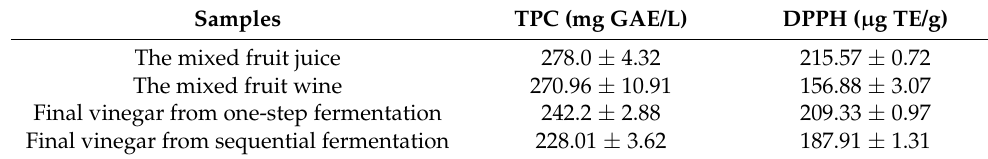
Table 2. Total phenolic acid and antioxidant activity of fruit vinegar during